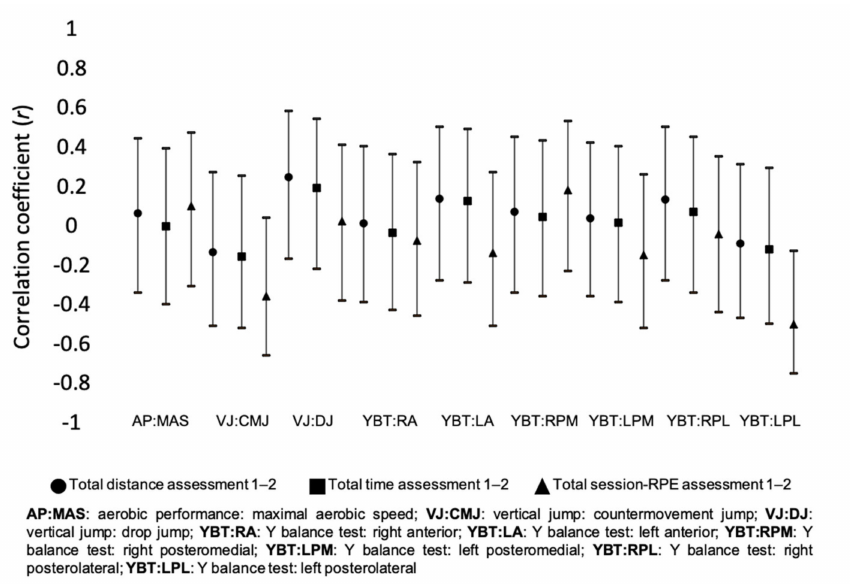
Figure 2. Correlation of accumulated training load variables between assessment 1 and 2.